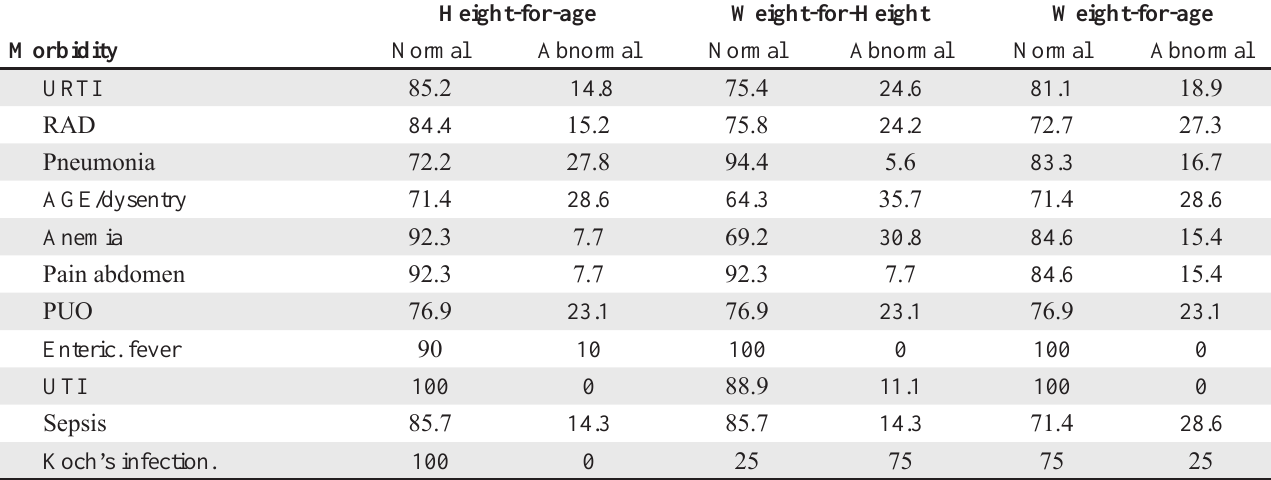
Table 3 : Percentage of children with normal and abnormal anthropometry with Height-for-age Weight-for-Height Weight-for-age